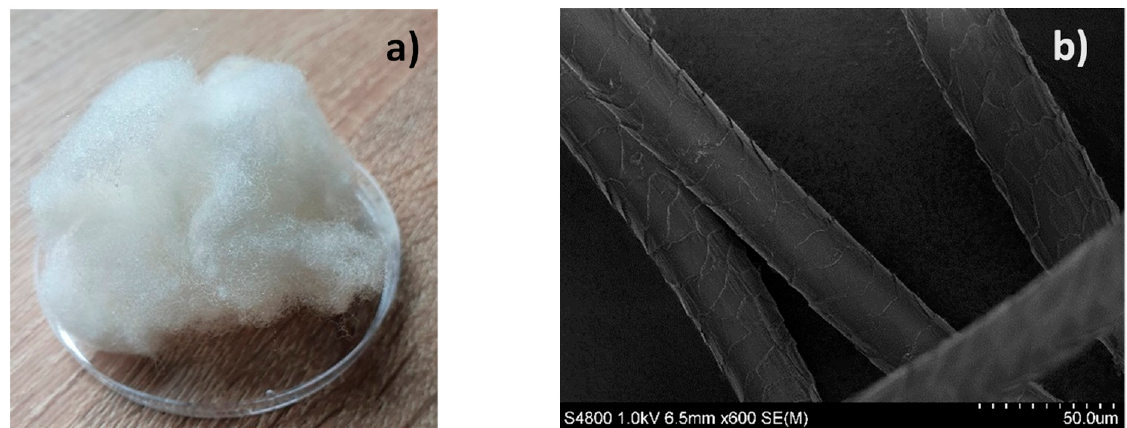
Figure 1. Photo of a wool ball ( a ) and individual fibers by SEM ( b ).